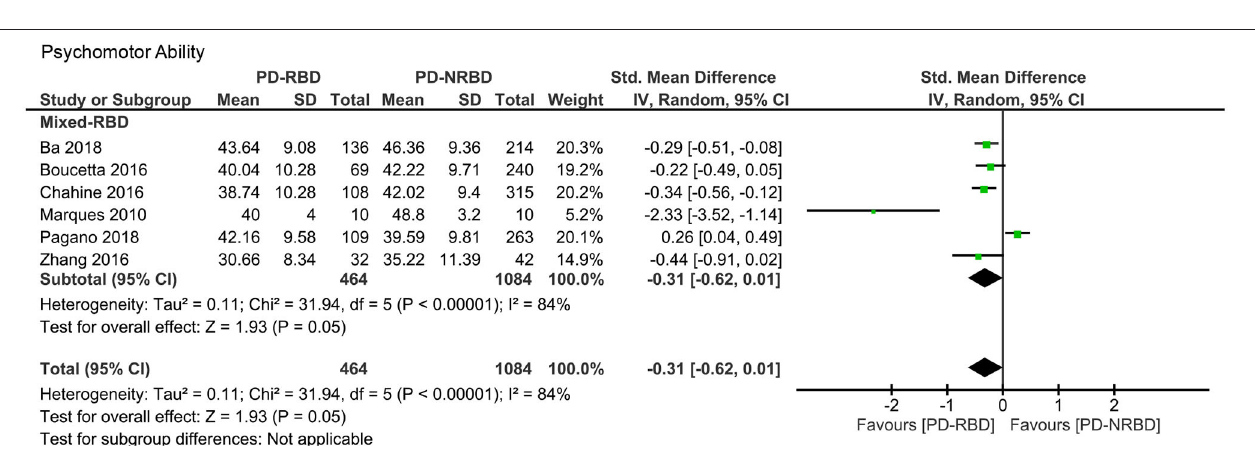
FIGURE 8 | Forest plot for psychomotor ability displaying effect size calculated using a random-effects model. SD , standard deviation; Std. Mean Difference , standardized mean difference; CI , confidence